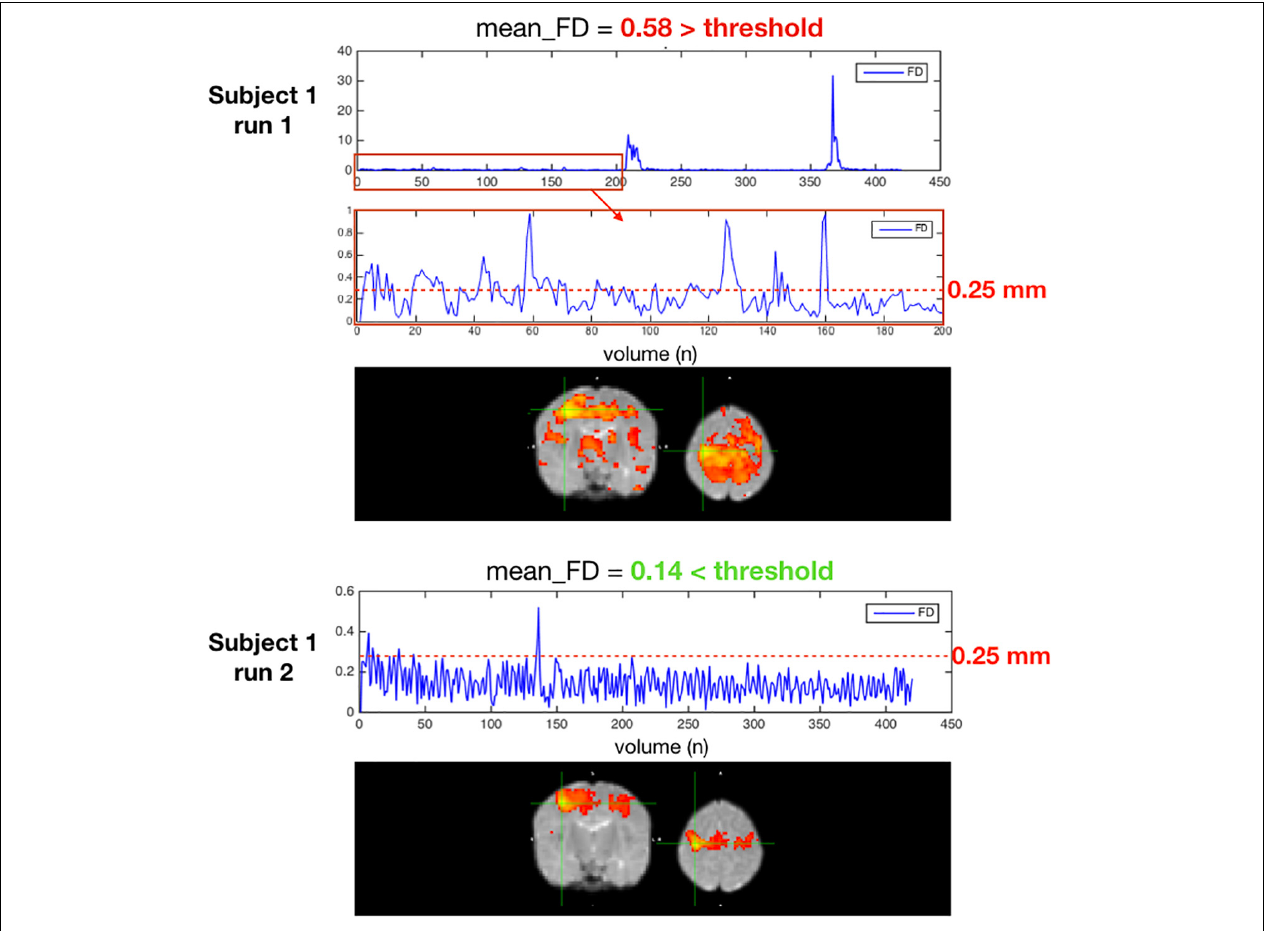
FIGURE 10 | Two acquisitions of a high motion subject, run 1 excluded for having an average FD ≥ 0.25 mm, run 2 kept with an average FD < 0.25